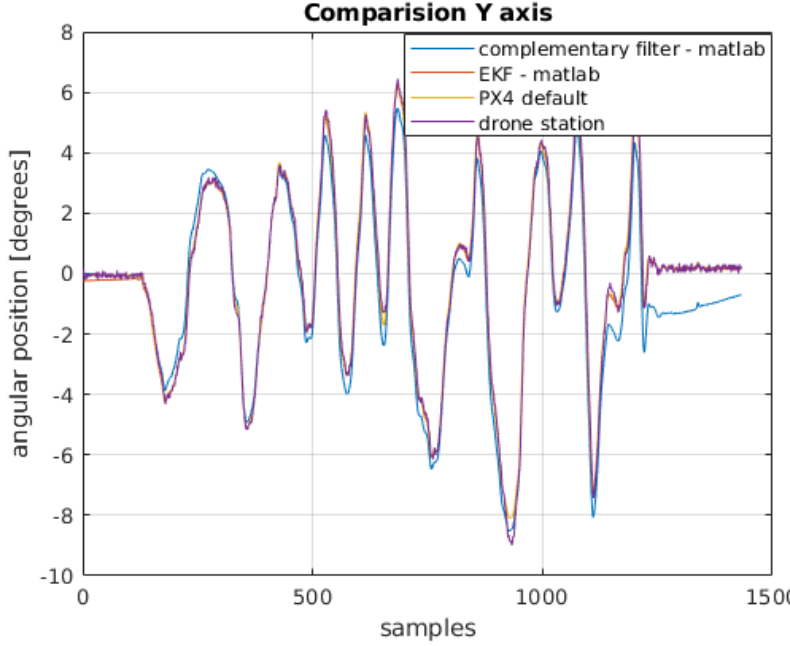
Figure 14. Comparison of the angular position obtained from the filters with the physical position for the Y-axis.